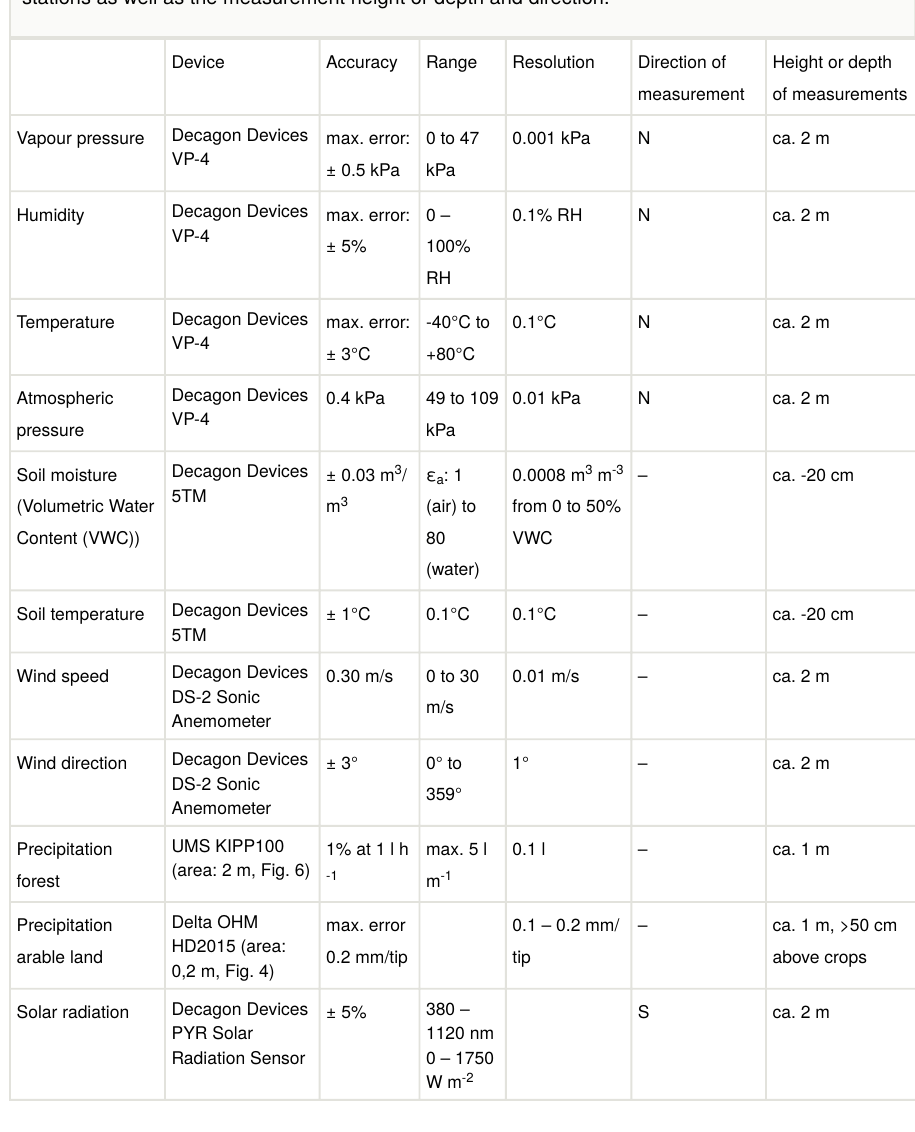
The following sensors were used (see Table 1 for speci fi cations): Table 1. Information on the device name, accuracy, resolution and range of the sensors of the weather stations as well as the measurement height or depth